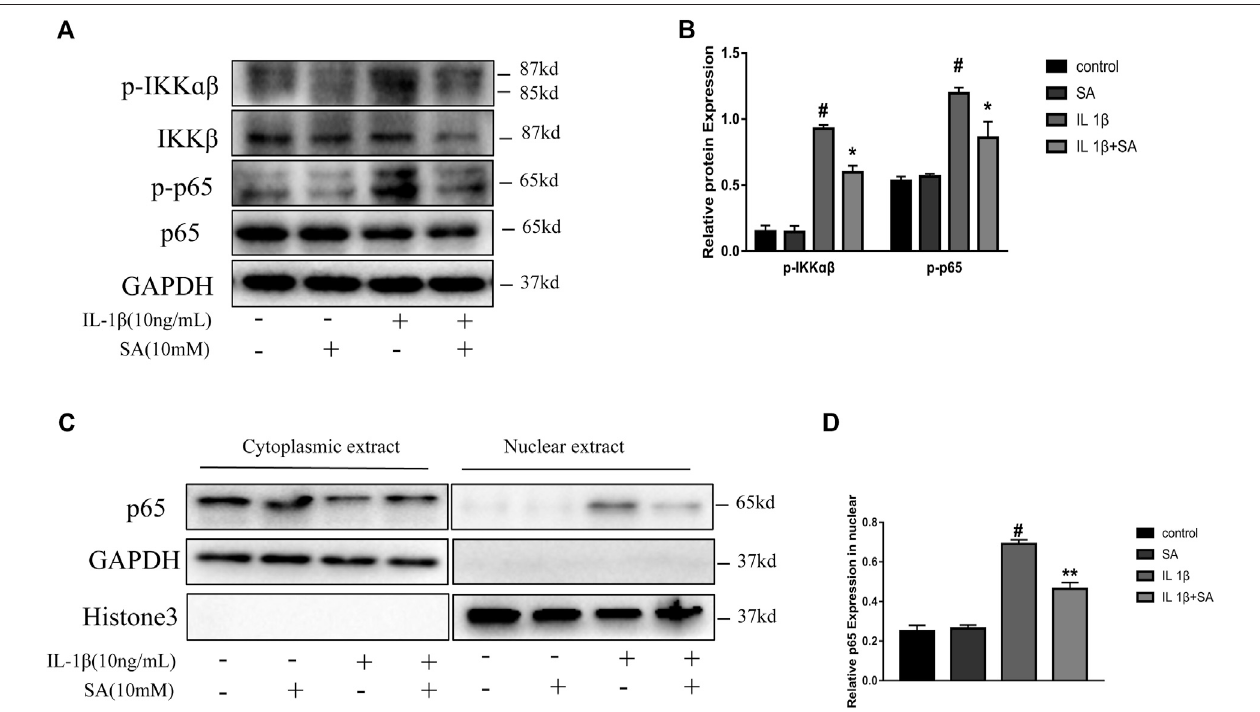
FIGURE6| SAmitigatesIL-1 β -inducedactivationoftheNF- κ Bsignalingpathway. (A,B) Representativewesternblotsandquanti fi cationdatashowing p -IKK α / β ,IKK α / β , p-p65, and p65 expression in cells treated as described above. (C,D) Representative western blots and quanti fi cation data showing cytoplasmic P65 and nuclear P65 levels in cells treated as described above. The data are shown as the mean ± SD ( n (cid:2) 3). # p < 0.05 vs. the control group; ** p < 0.01, * p < 0.05vs. the IL-1 β group.